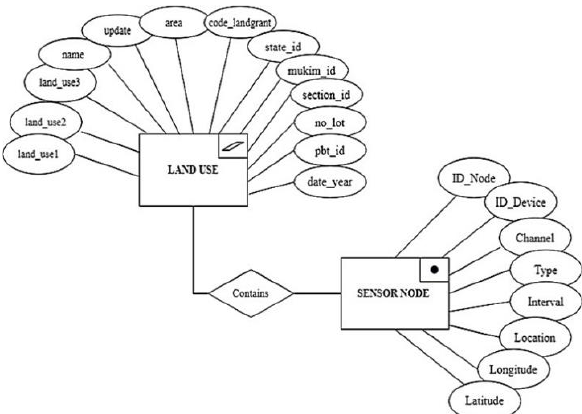
Figure 6. ER Diagram of Web-based GIS for Smart water monitoring.